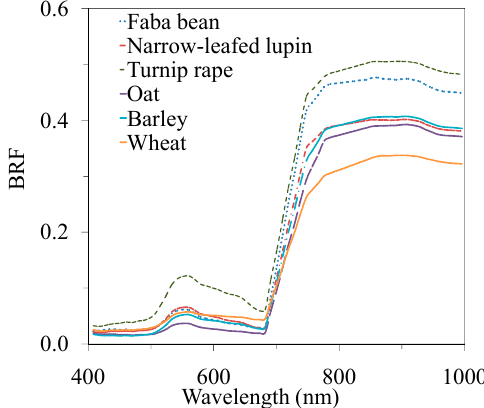
Figure 3. Averaged canopy reflectances (spectral hemispherical-directional reflectance factors) of six crops species acquired from AISA imaging spectrometer data.